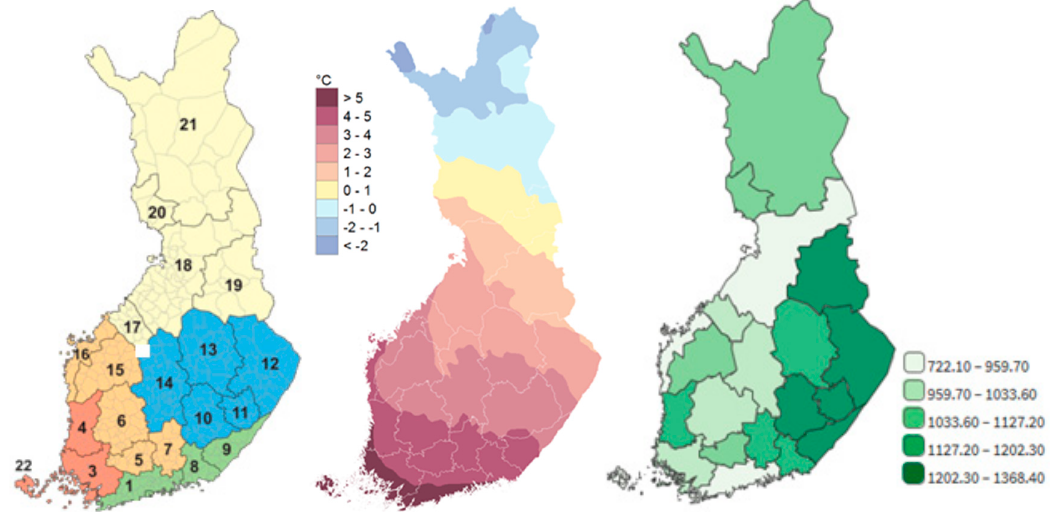
Figure 1. Hospital districts ( left ; 2011 regionalization), annual mean temperature in Finland in the climate normal period 1981–2010 ( middle , [29]) and mortality (1/100,000) by hospital district in 2014 ( right , [30]).